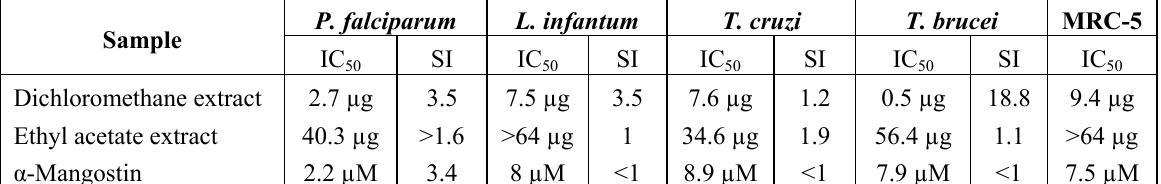
Table 4. Antimicrobial activity (IC